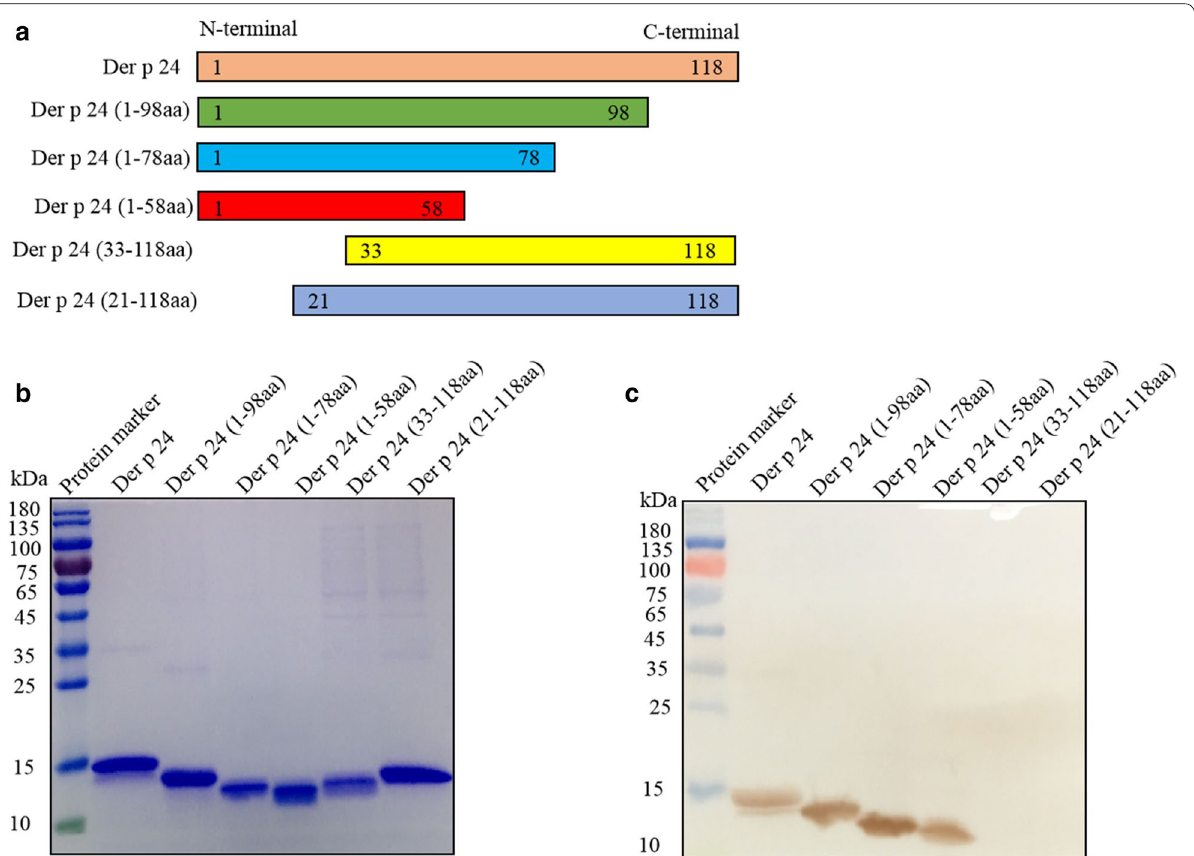
Fig. 2 Localization of an IgE epitope of Der p 24 to the N‑terminus. a Schematic representation of truncated Der p 24 fragments used for IgE epitope mapping. b SDS‑PAGE analysis of rDer p 24 and five truncated forms of rDer p 24 after Ni‑NTA resin purification. The gel was stained with Coomassie Brilliant Blue. c IgE binding activity of truncated Der p 24 fragments determined by IgE‑western blots with pooled sera from